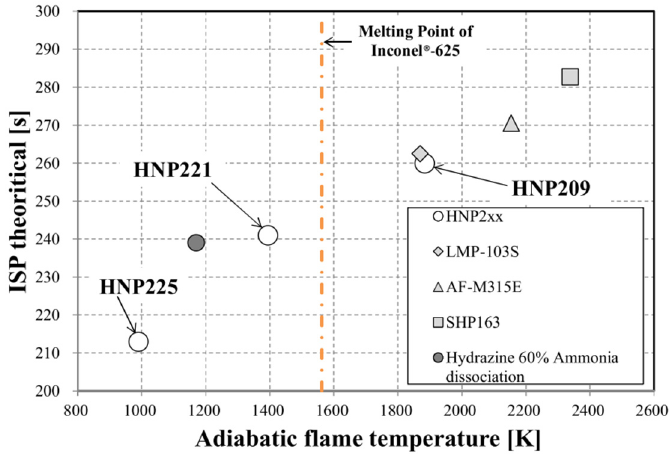
Figure 2. HNP2xx green monopropellants family performance chart compared to other EILs. Adapted from Igarashi and Matsuura 2017 [25] with permission.